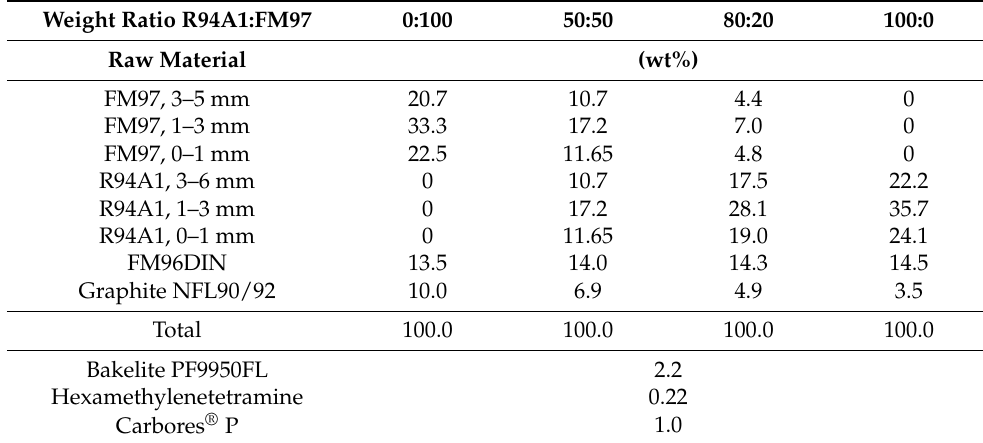
Table 2. Mixture